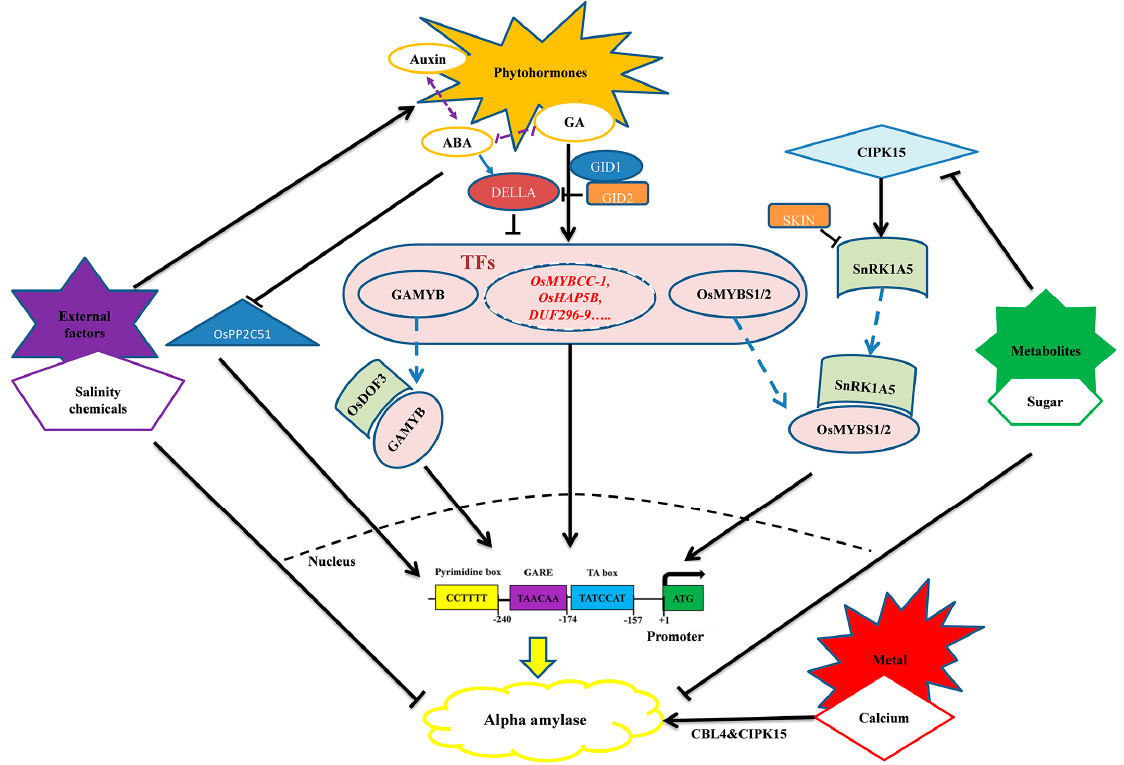
Figure 3. A proposed model of regulation of alpha-amylase including phytohormone, signaling, abiotic stress, and metabolites regulation. Information for developing this model was obtained from [14,51,55,83–89]. The transcription factors that are written in red are part of a continuing experiment and have not been verified (Unpublished data).